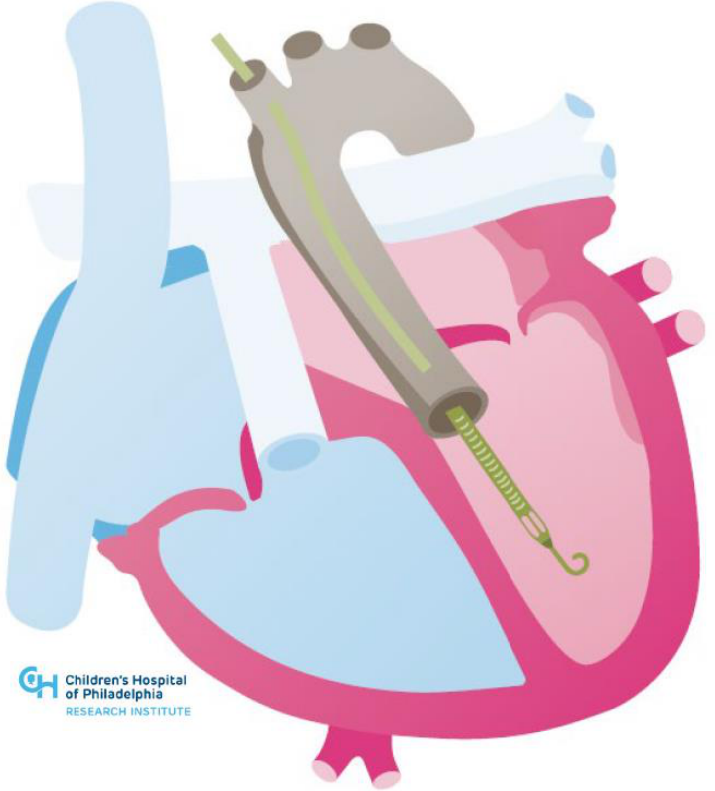
Figure 4. Illustration of Impella in congenitally corrected transposition of the great arteries.